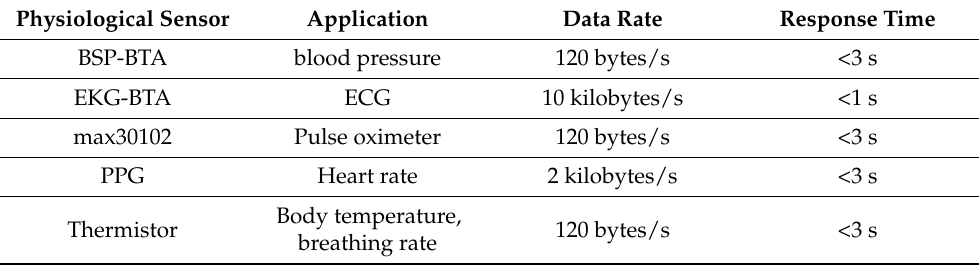
Table 1. Information pertaining to the various sensors used in this work.